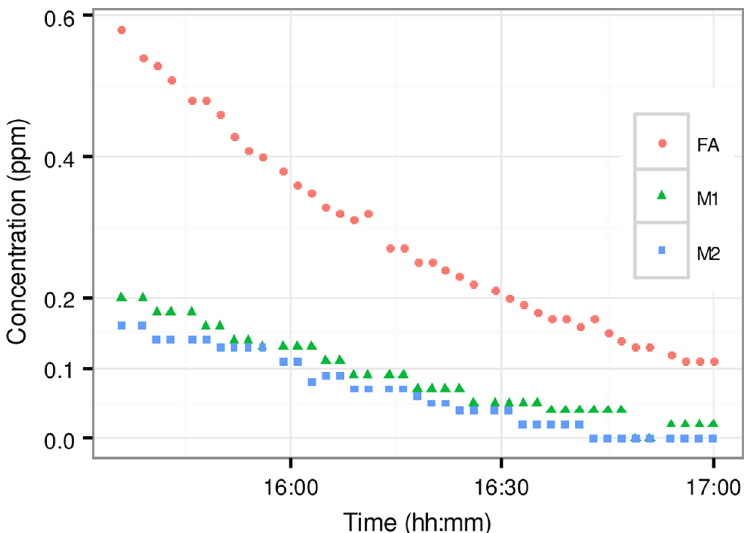
Fig 7. Response of phones (M1 and M2) and formaldehyde analyser (FA) to varying concentrations of formaldehyde in